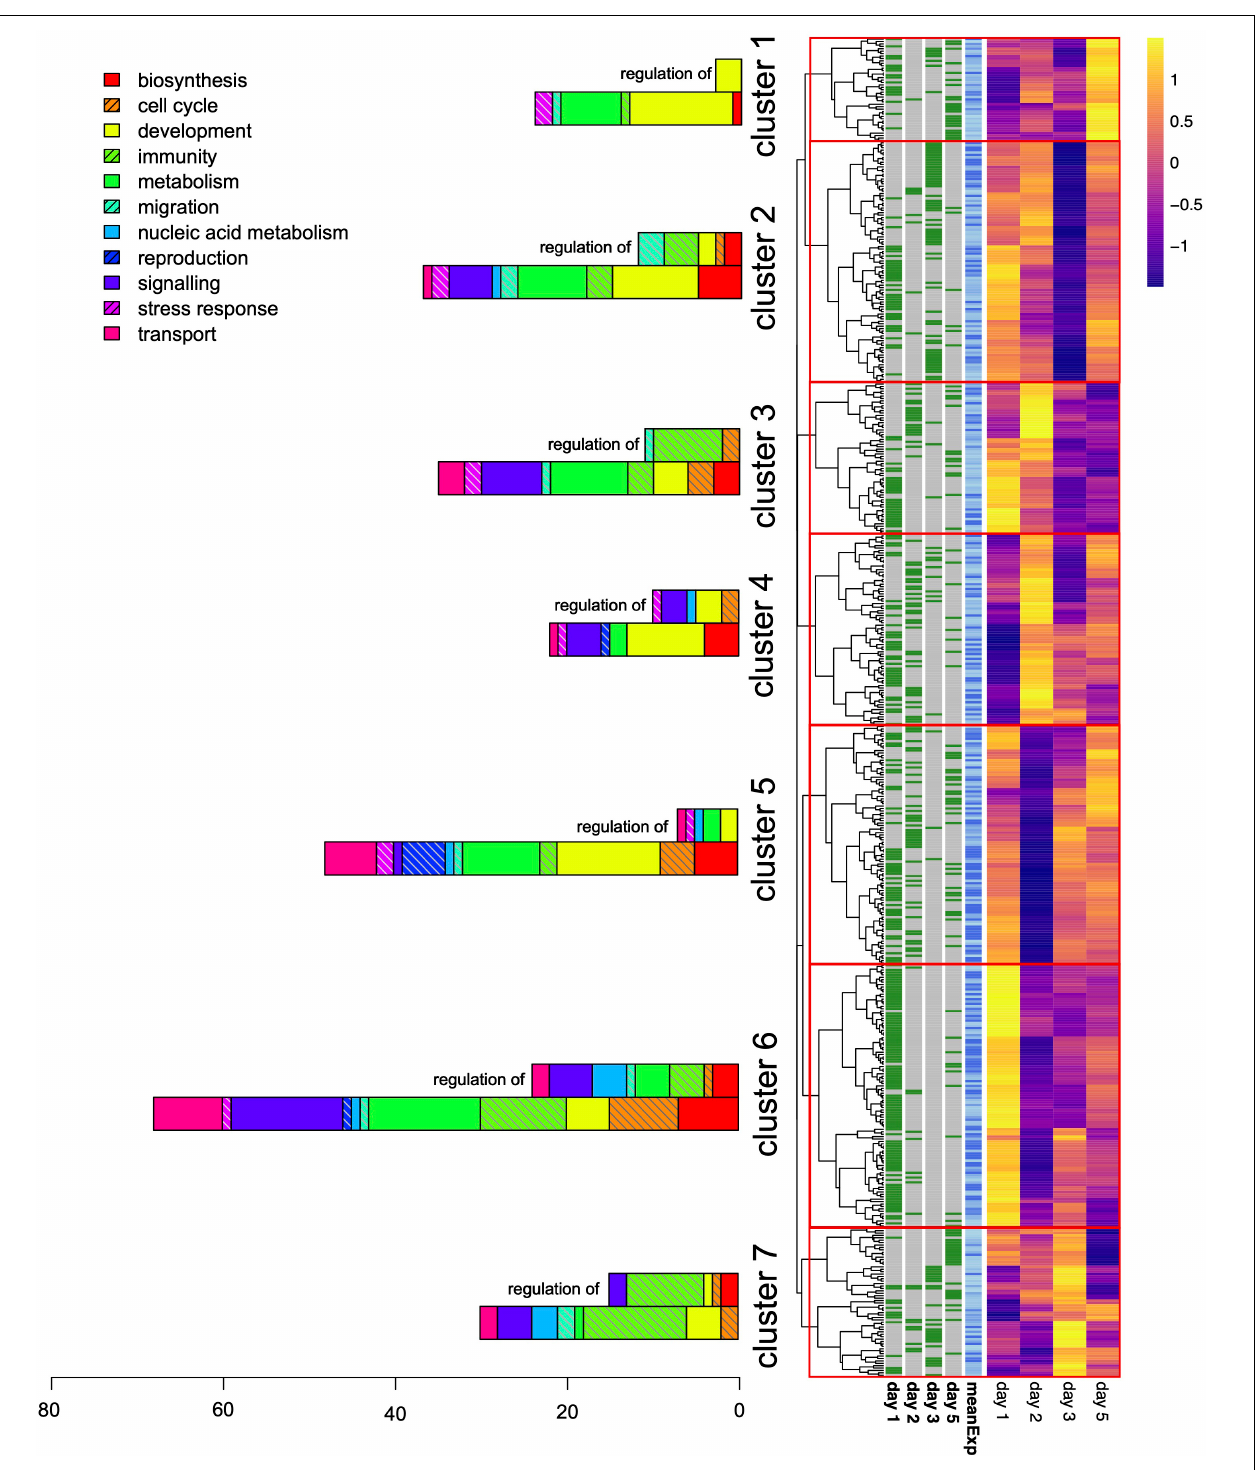
FIGURE 3 | Differentially expressed genes after oyster translocation. The heatmap shows genes differentially expressed between the oyster origins on different days after translocation. Each line represents one of the 555 significantly regulated genes and expression values were standardized by gene showing the temporal dynamics of up- or down regulation of Texel relative to Sylt oysters. The overall mean expression level of each gene is shown in the blue column, and the four collumns left of that indicate on which day a gene was significant. Clustering was performed based on the expression heat map and split clusters on the deepest possible branching point. Bar charts on the left show the number and processes of GO terms enriched within that cluster. GO terms associated with regulation were the most common terms and are therefore in a separate column for each cluster.